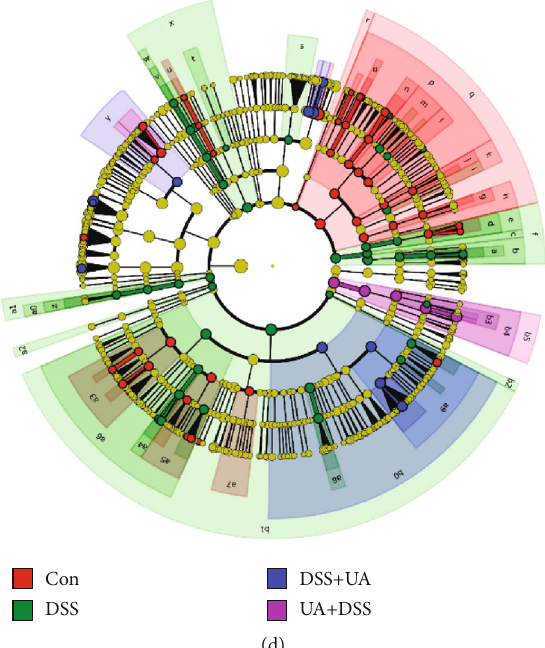
Figure 6: Analysis of the di ff erential microbial community among the group. (a) Rarefaction curve of microbial community richness of Con, DSS, UA+DSS, and DSS +UA groups. (b) Alpha diversity index (Chao1_index) of intestinal within groups. (c) Alpha diversity index (Shannon_index) of intestinal within groups. (d) Cladogram of the LDA value from the Con, DSS, UA+DSS, and DSS +UA groups. The Kruskal-Wallis H test was used to analyze the signi fi cant di ff erences between groups by R .